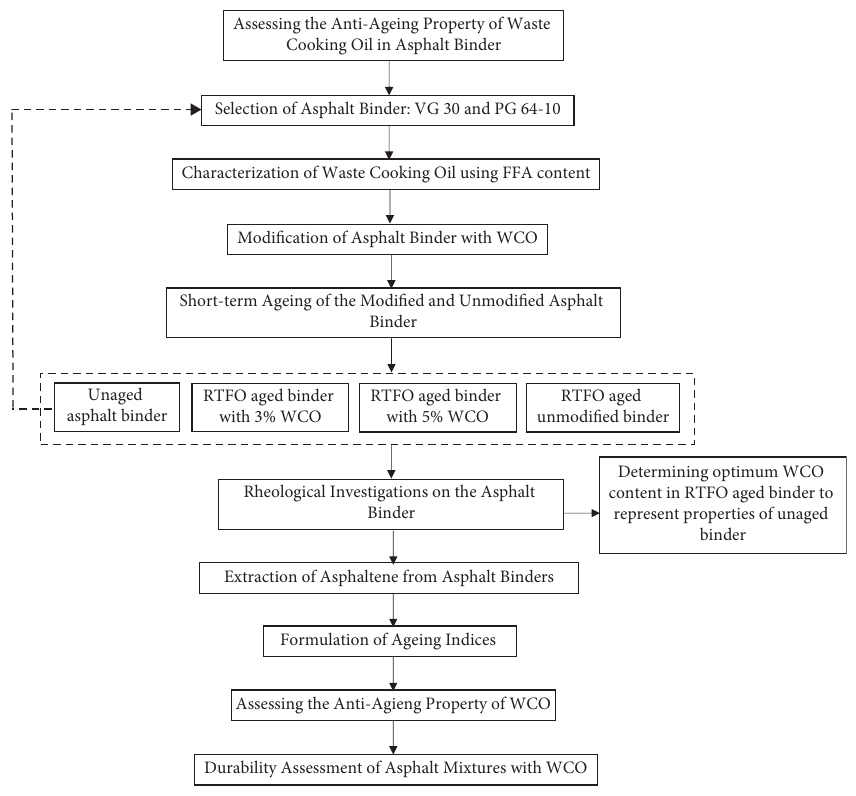
Figure 2: Research